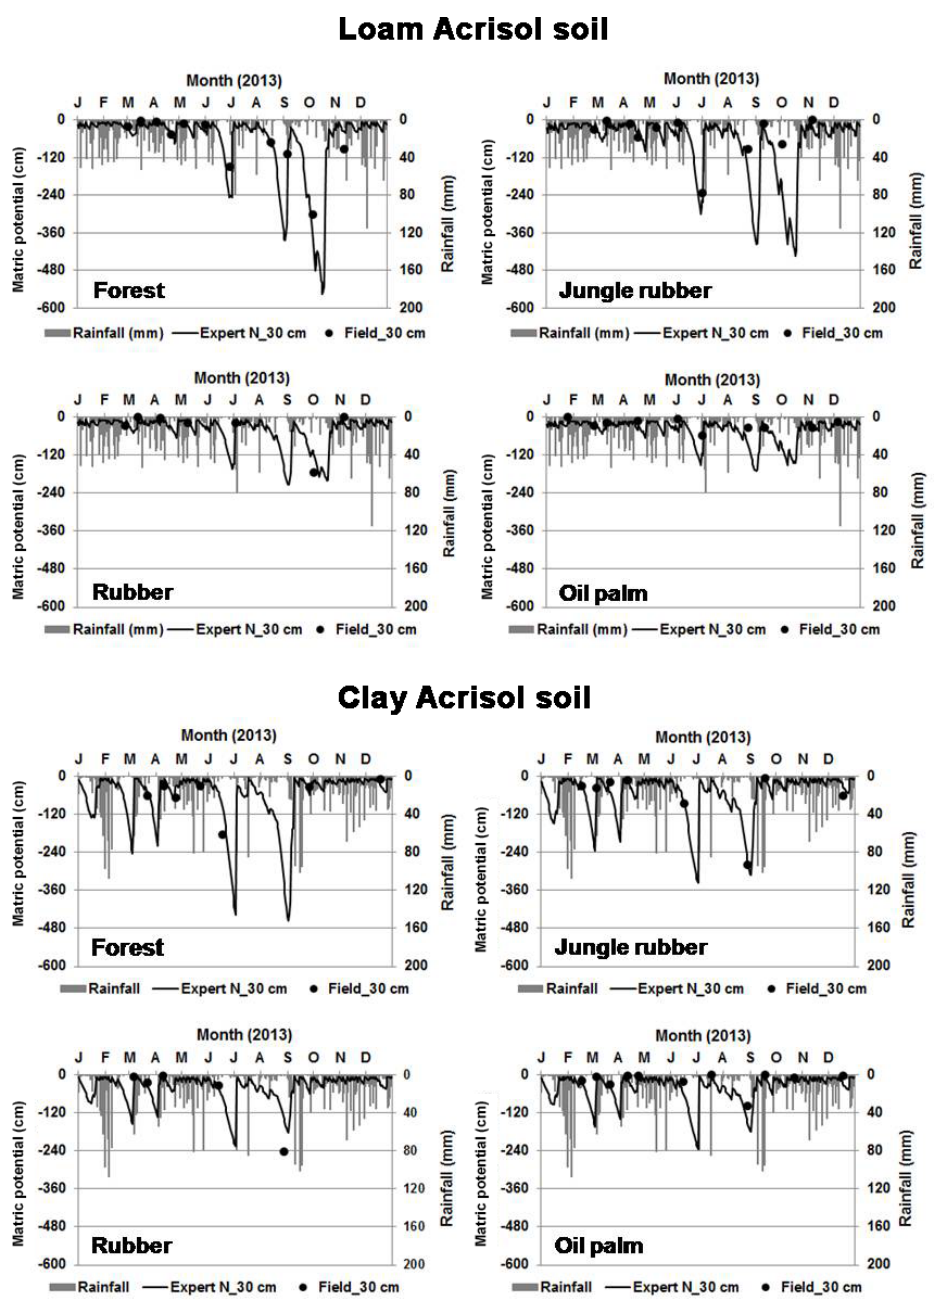
Figure B2. Validation between Expert-N-modeled and field-measured matric potential at a depth of 0.3m in different land uses within the loam and clay Acrisol soils in Jambi, Sumatra,